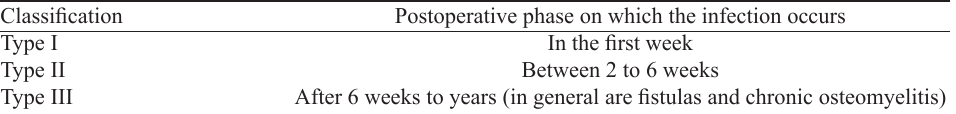
Table 1. The classification proposed by Pairolero based in the postoperative period that installs the infectious process in the surgical wound.